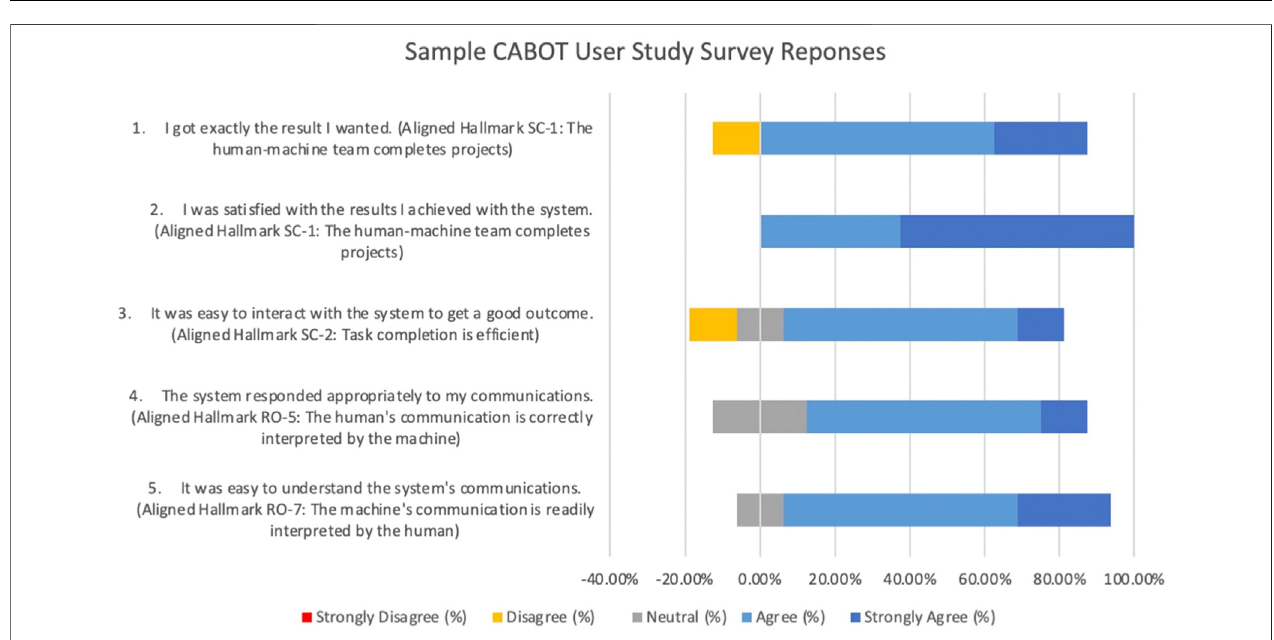
FIGURE 8 | Sample chart generated by the authors from results of Participant Surveys from IHMC User Study (Ian Perera, unpublished data, July 2020) on CABOT BlocksWorldSystem(Pereraetal.,2018).SurveyitemsareshownalongwiththeiralignedHallmarksandparticipantassessments.Eightindividualsparticipatedinthisstudy.